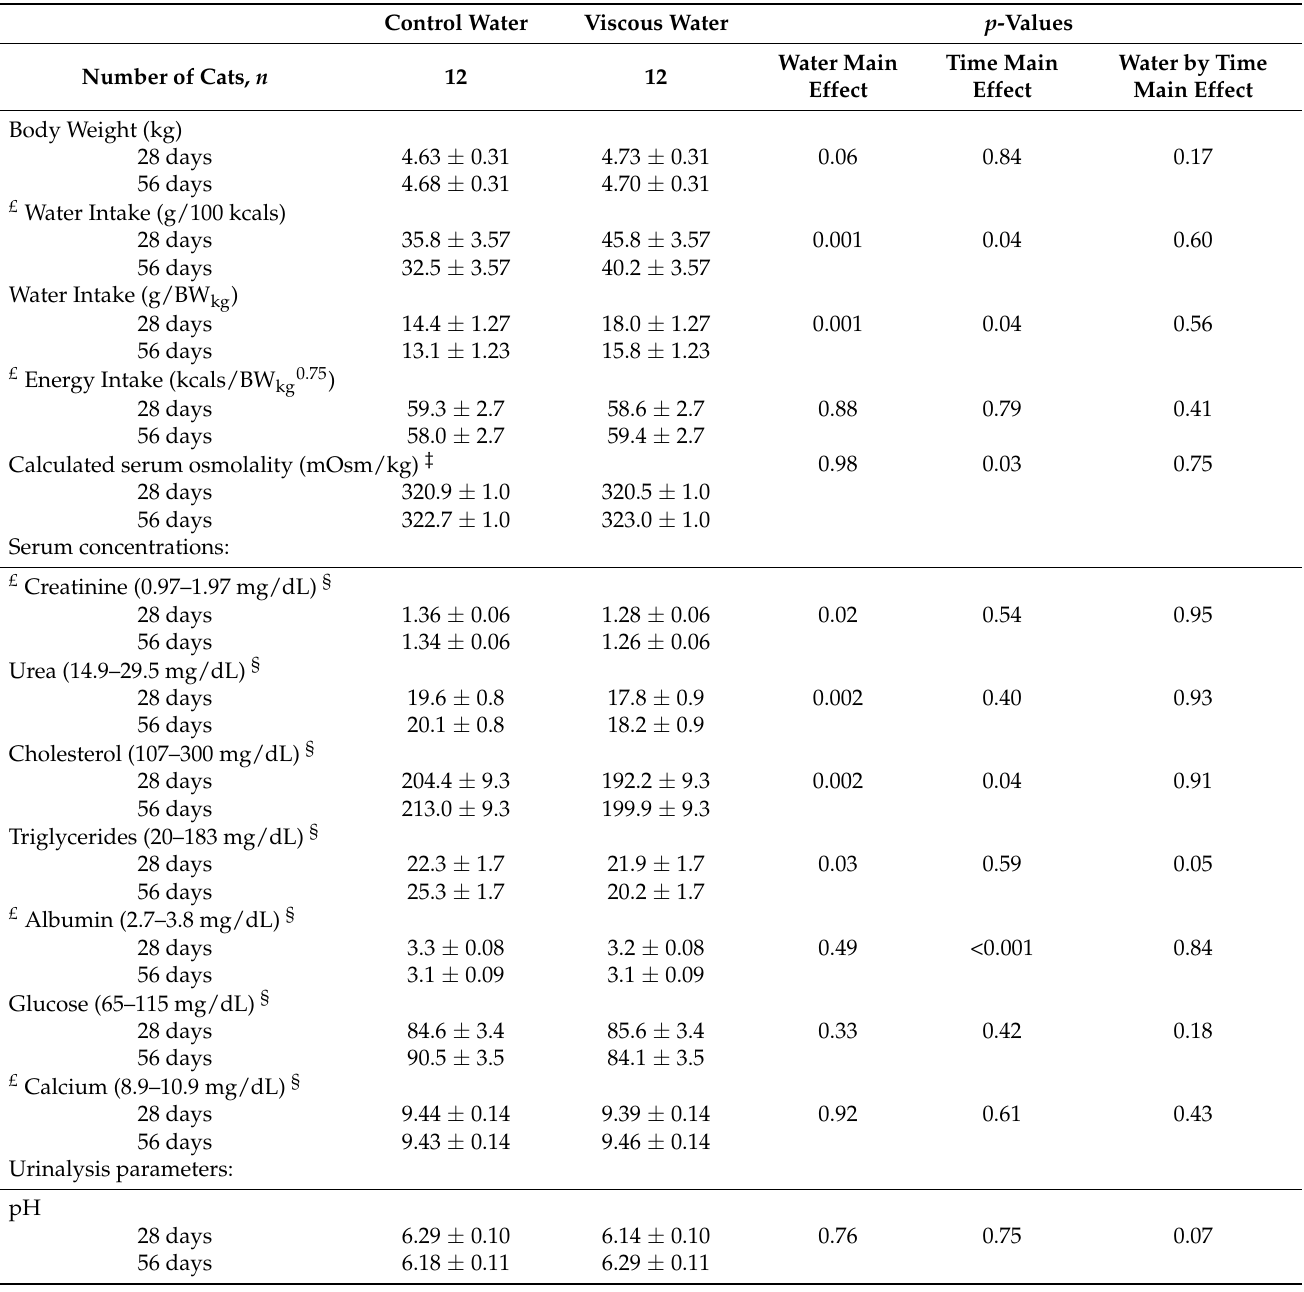
Table 1. Body weight, water intake, energy intake, concentrations of serum analytes, and urinalysis parameters (mean ± SEM) of cats at baseline (initial) and after consuming control (deionized) water or 1% methylcellulose (viscous) water for 28 and 56